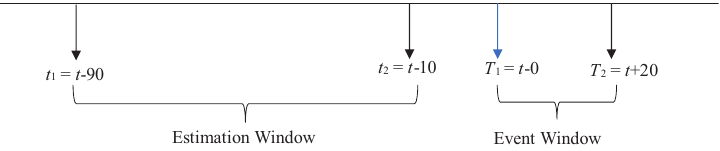
Figure 1. Event study